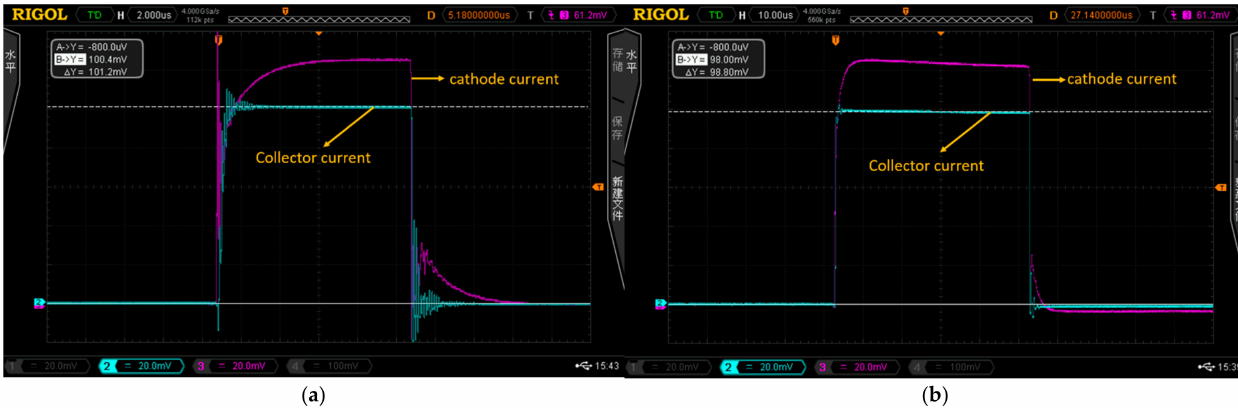
Figure 11. The current waveforms measured by oscilloscope with ( a ) pulse durations of 10 µ s and ( b ) pulse durations of 50 µ s. Both cases have the same repetition rates of 100